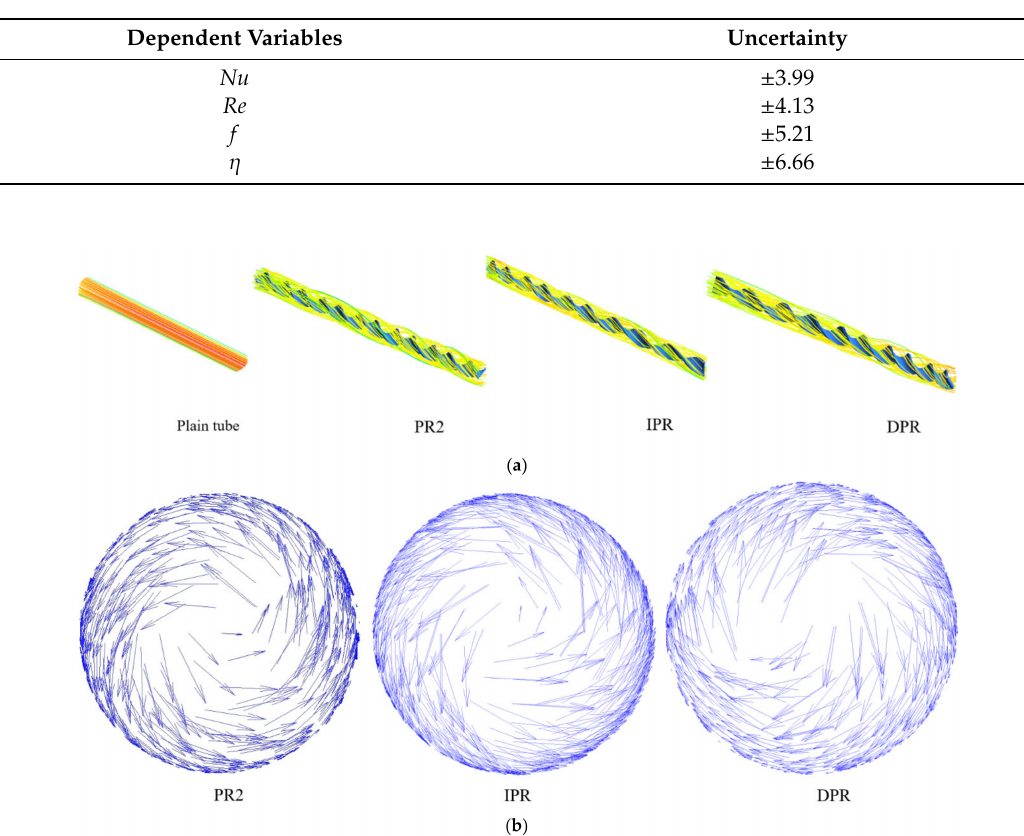
Table 6. Uncertainty of dependent